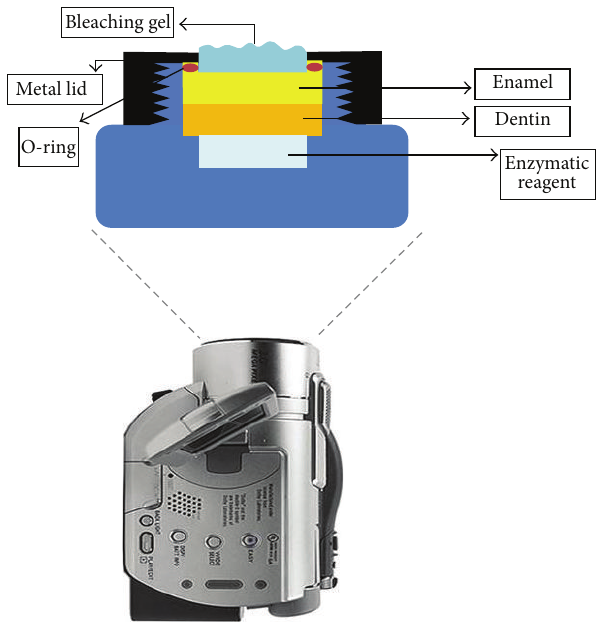
Figure 1: Schematic drawing of the sample holder.